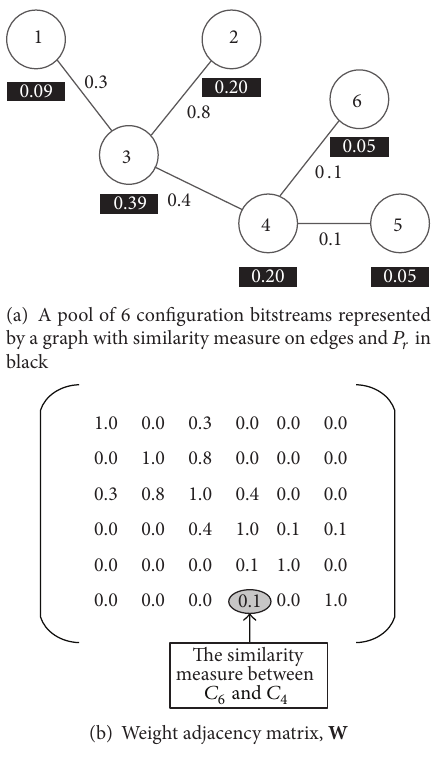
Figure 8: An example of configurations ranking.